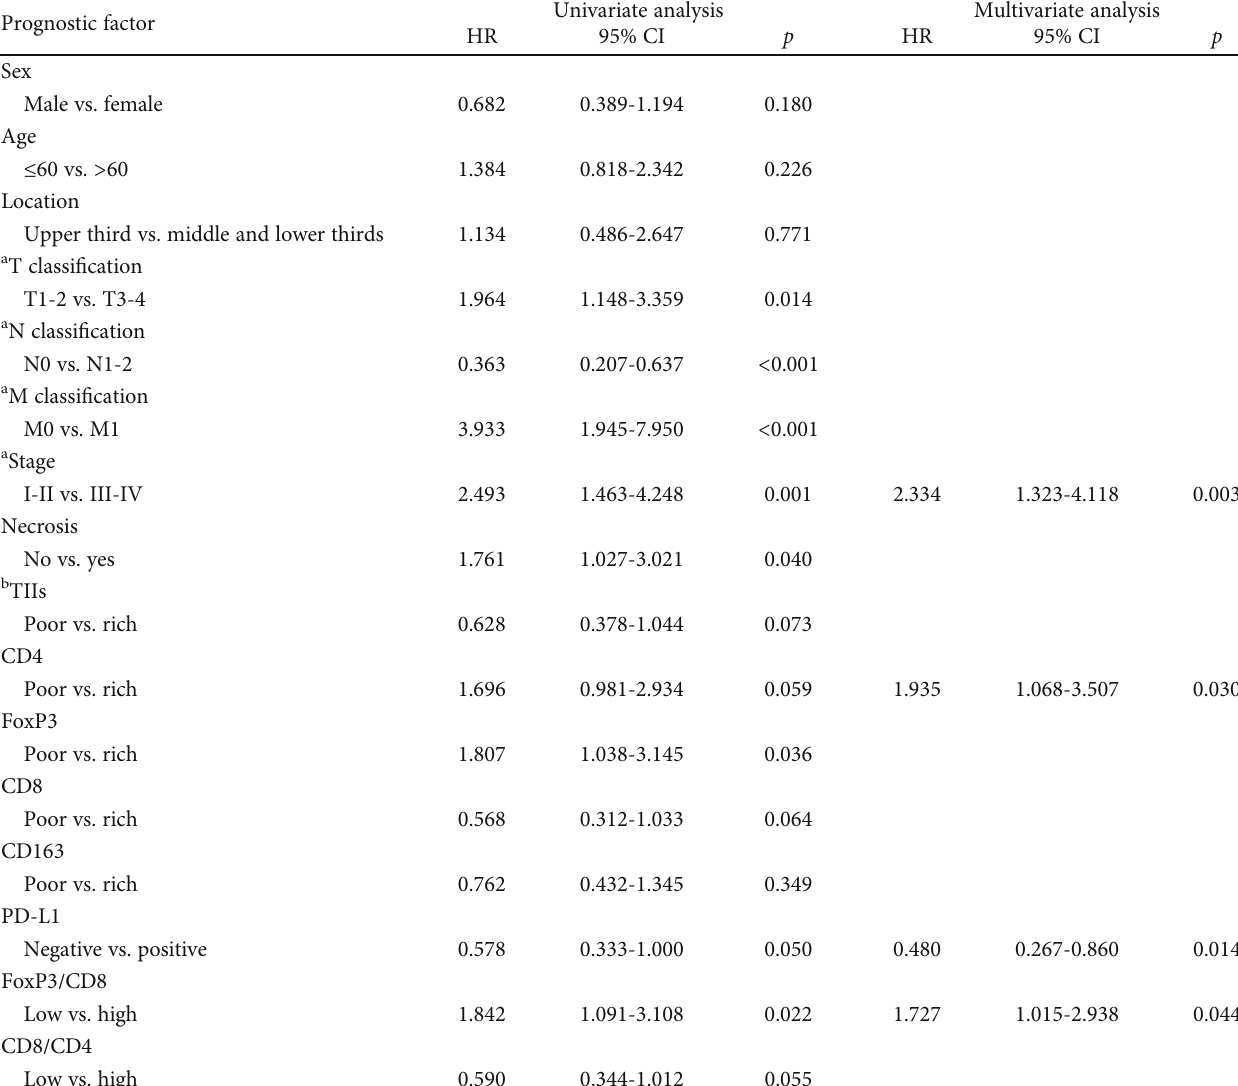
Table 2: Univariate and multivariate analyses for overall survival in